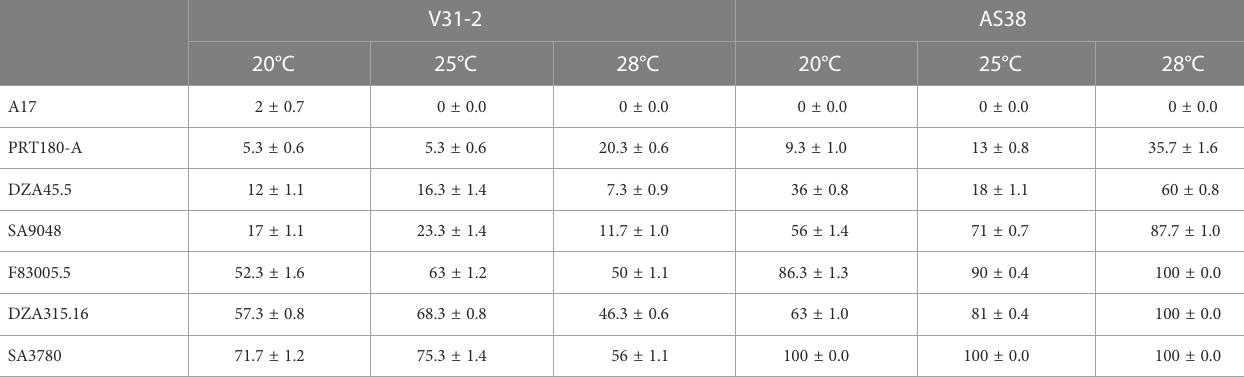
TABLE 2 Colonization rate of seven M. truncatula accessions infected by V. alfalfae